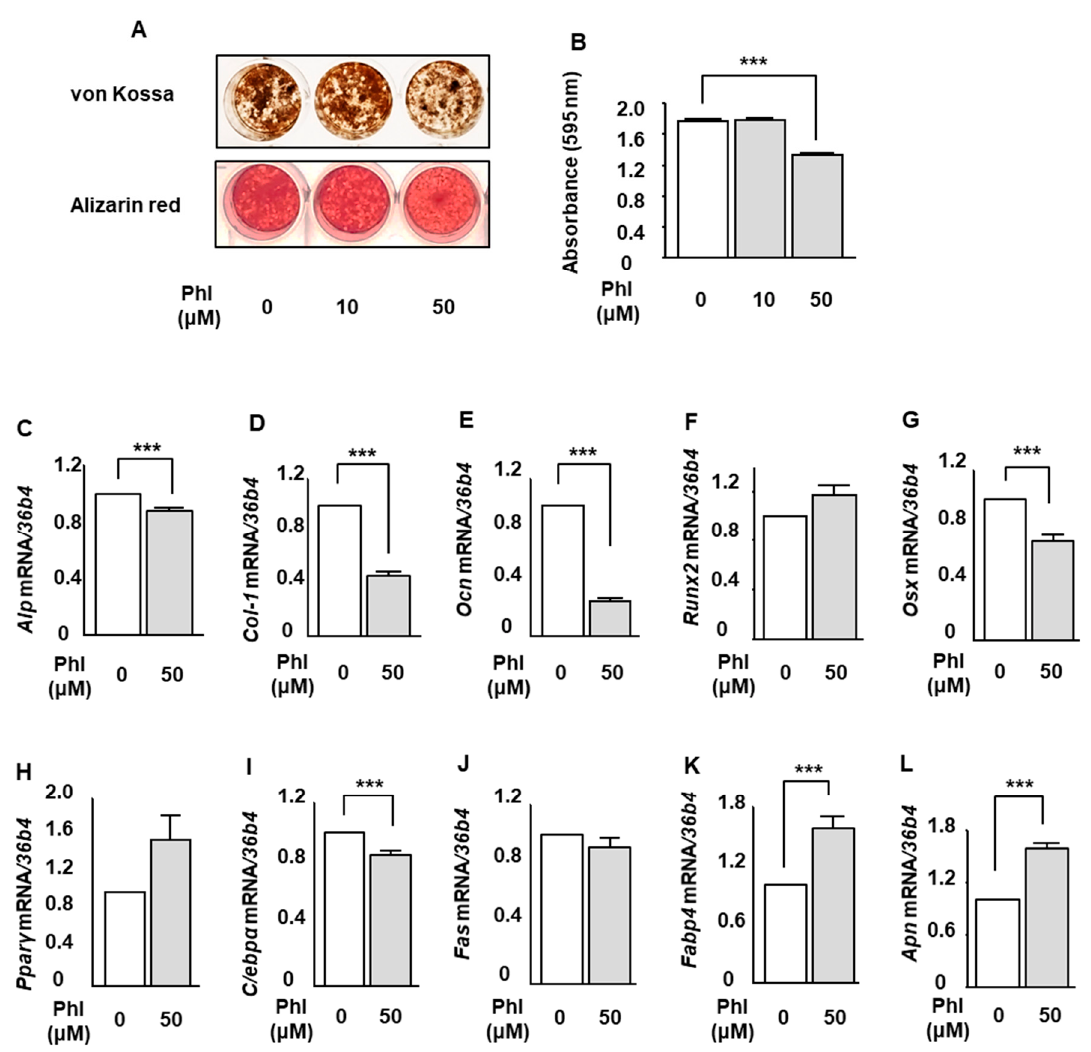
Figure 3. The effects of phloretin on mineralization and expression of osteoblastogenic and adipogenic markers in MC3T3-E1 cells. ( A , B ) After reaching confluence, MC3T3-E1 cells were incubated in osteoblast differentiation medium with 0, 10, and 50 µM phloretin, and von Kossa staining, Alizarin red staining, and its quantification were performed on day 14. Quantification results are expressed as mean ± SE ( n = 6). *** p < 0.001. ( C – L ) After reaching confluence, MC3T3-E1 cells were incubated in osteoblast differentiation medium with 0 and 50 µM phloretin. The mRNA expression of osteoblast differentiation markers ( Alp , Col-1 , Ocn , Runx2, and Osx ) and adipocyte differentiation markers ( Ppar γ , C/ebp α , Fas , Fabp4, and Apn ) was examined on day 3 by real-time PCR. The results are expressed as mean ± SE ( n ≥ 5). *** p < 0.001. Phl; phloretin.